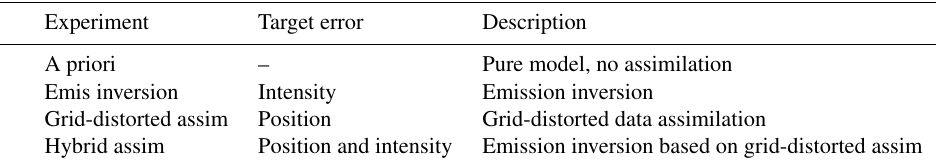
Table 1. Definition of assimilation